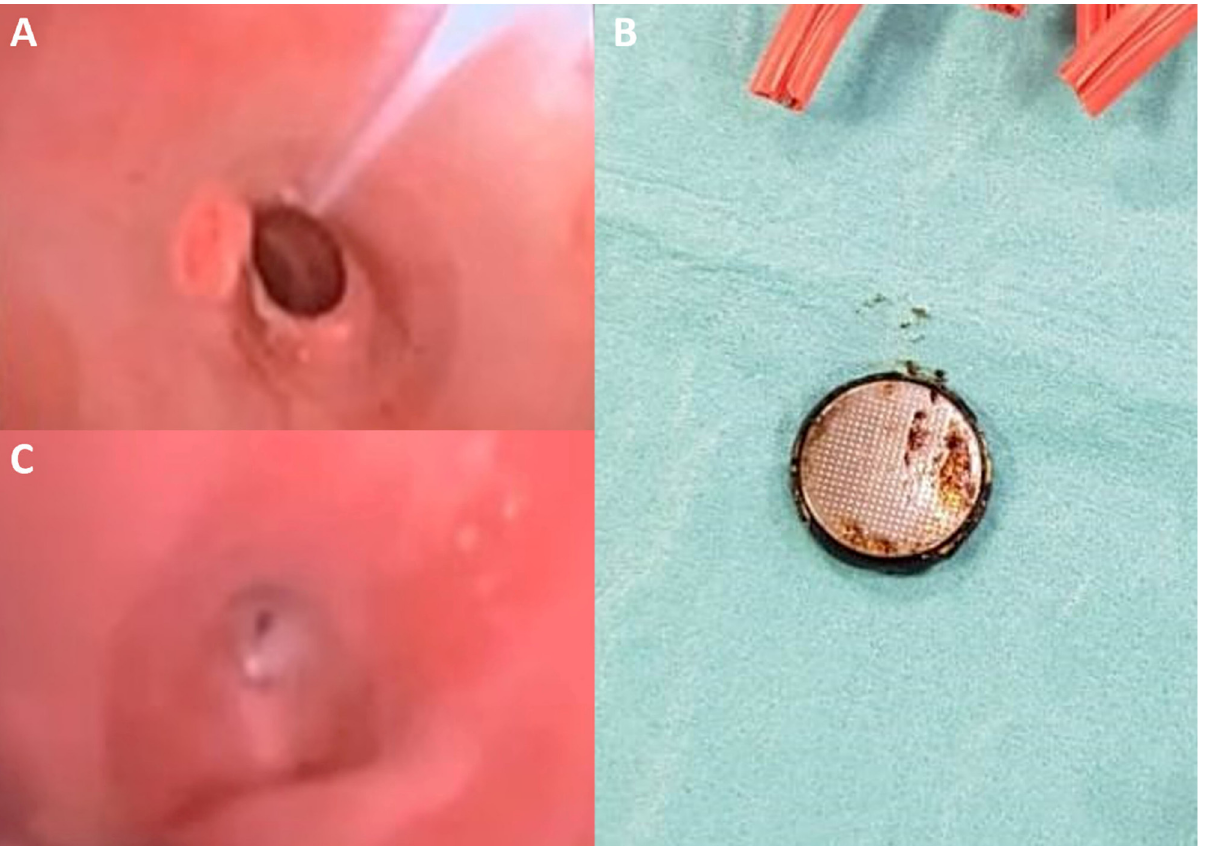
Figure 1. Esophagoscopy image shows the presence of a foreign metallic body (disk battery) in the middle esophagus ( A ), which was promptly removed ( B ). A repeated endoscopy performed 40-days after the first procedure, showed the persistence of TEF ( C ).